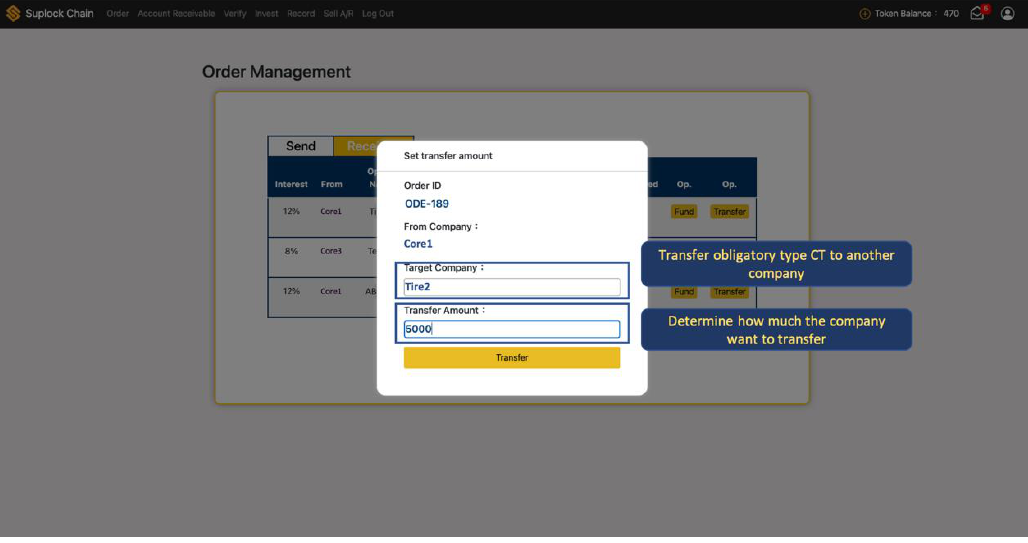
Figure A13. Module for tier1 company transferring CT to tier2 company.